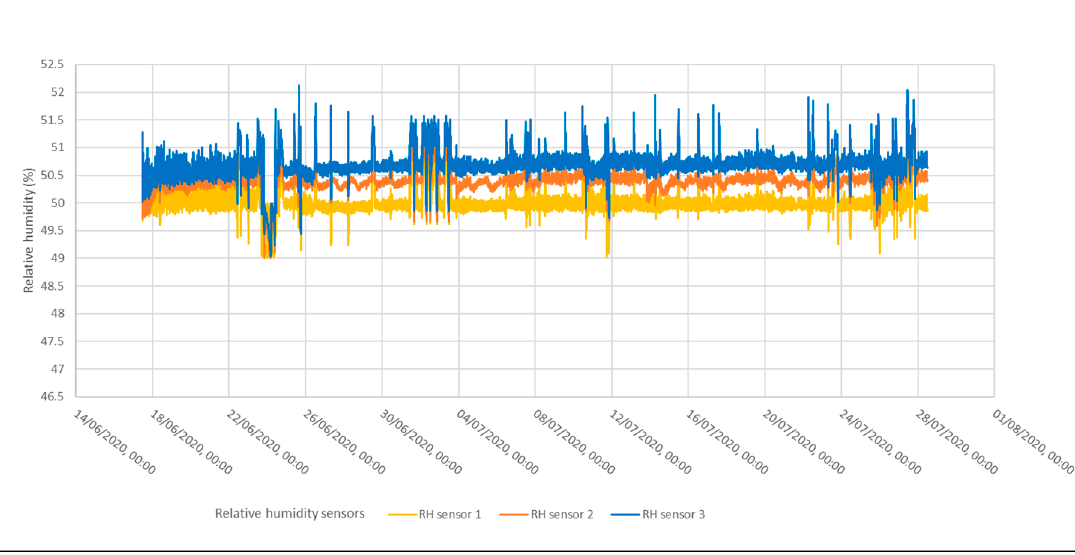
Figure 23. Box and whisker plot of temperature observations during test 2.